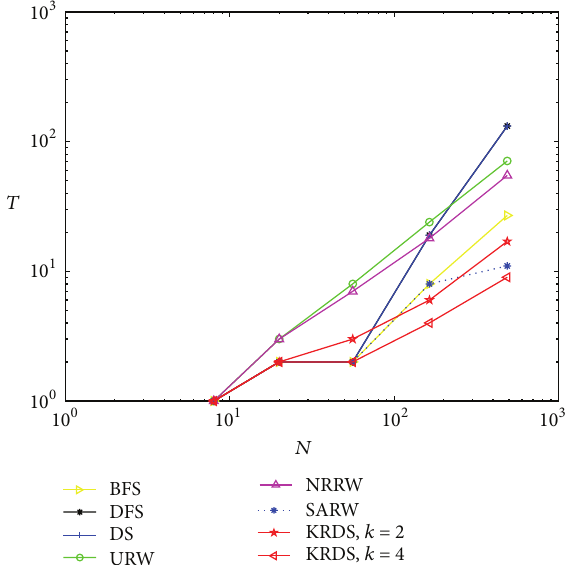
Figure 9: Plot of the average number 𝑇 of search steps versus the network size 𝑁 of the DMG in the log-log scale.